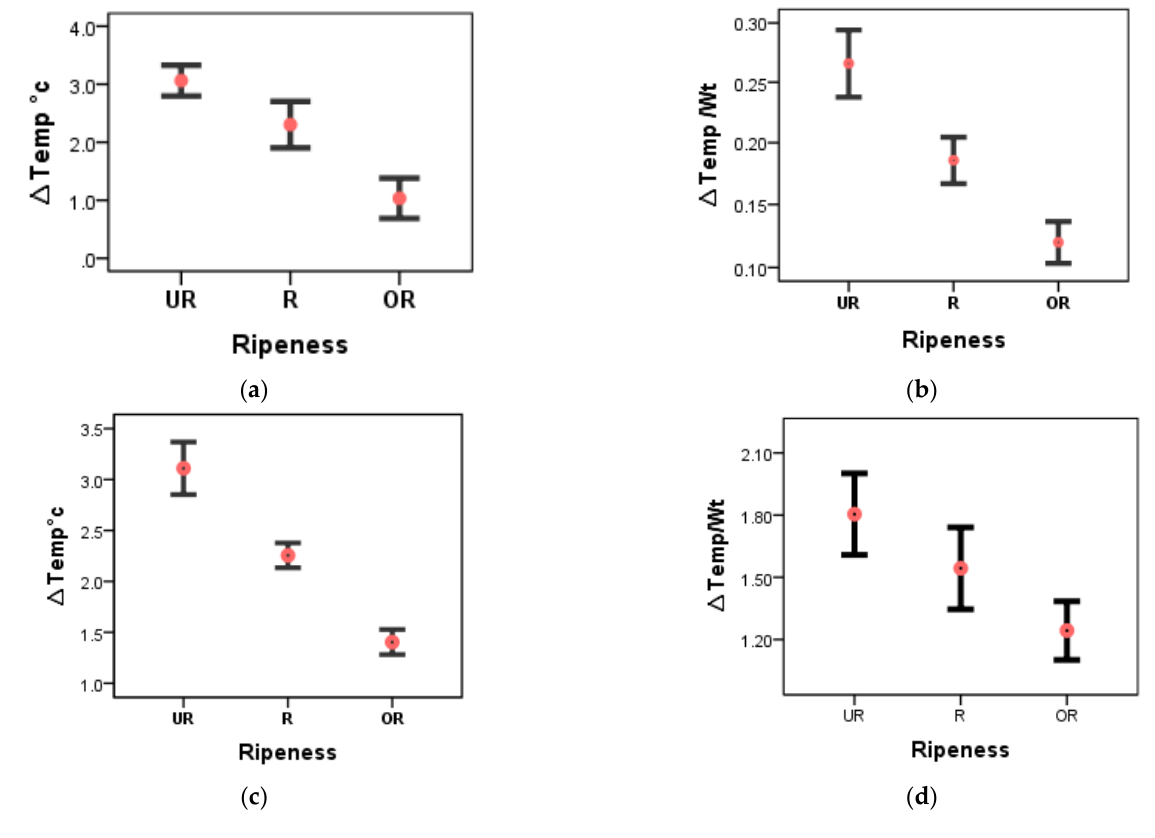
Figure 9. Error b ars of ∆Temp and ∆Temp/Wt: ( a , b ) first experiment, ( c , d ) second experiment. Figure 9. Error bars of ∆ Temp and ∆ Temp/Wt: ( a , b ) first experiment, ( c , d ) second